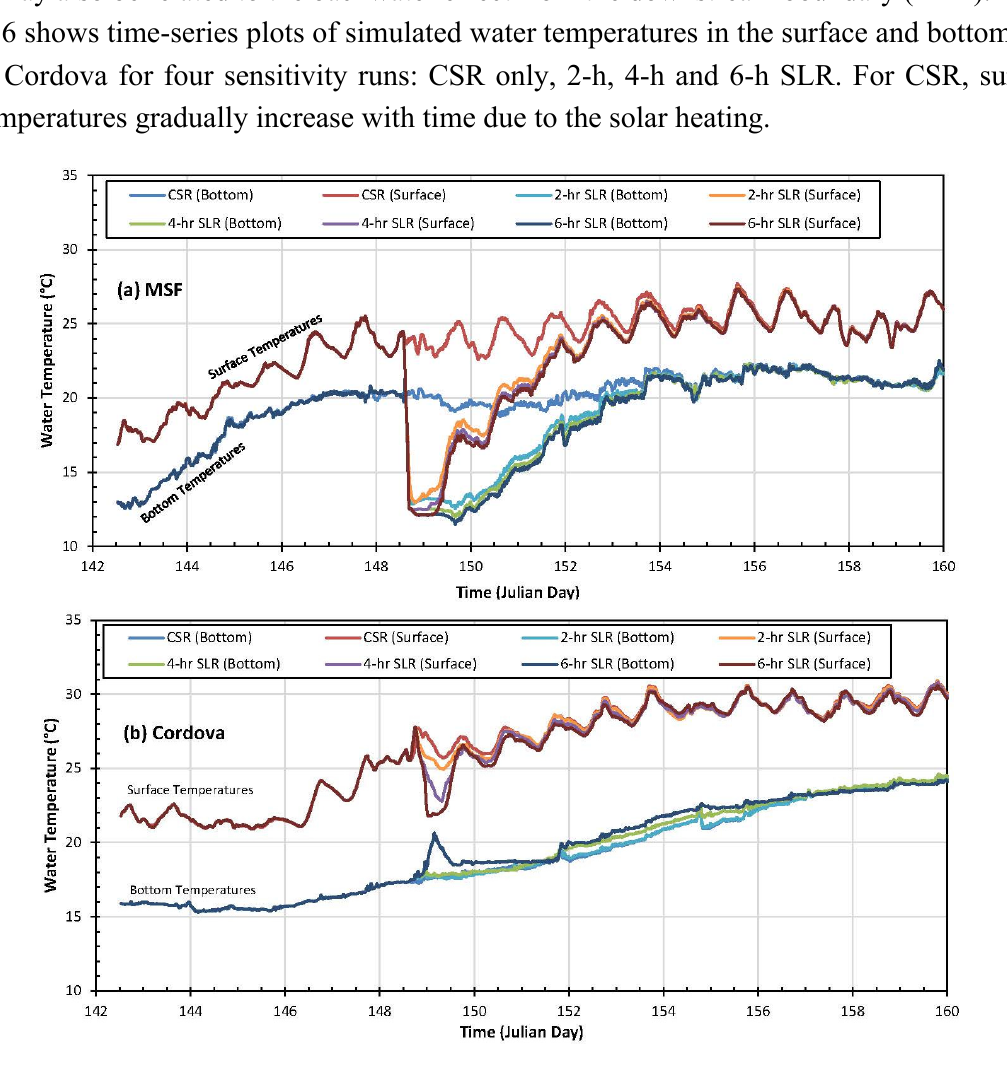
Figure 6. Time series of simulated water temperatures in the surface and bottom layers at MSF and Cordova for four sensitivity runs: CSR only, 2-h, 4-h and 6-h SLRs. ( a ): MSF; ( b ):